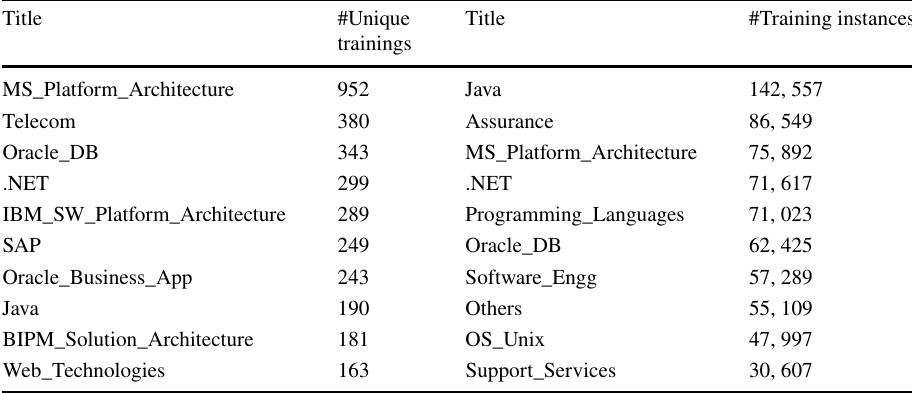
Table 3 Top 10 technology groups in terms of #available trainings and #trainings